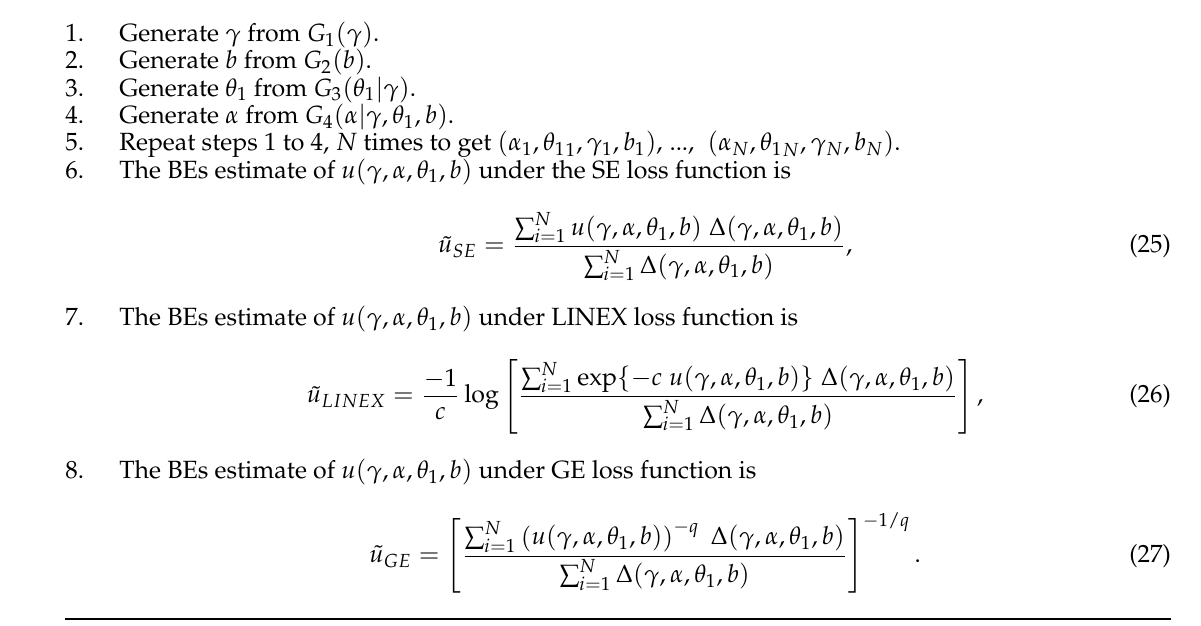
Algorithm 1 Importance